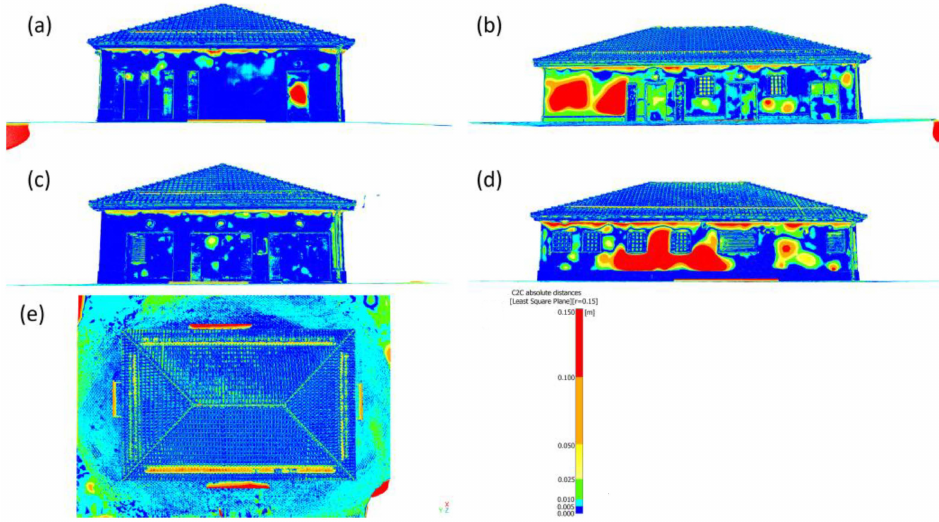
Figure 13. The comparison between TLS and image-based point cloud (ContextCapture): ( a ) elevation 1; ( b ) elevation 2; ( c ) elevation 3; ( d ) elevation 4; ( e ) top view on the study